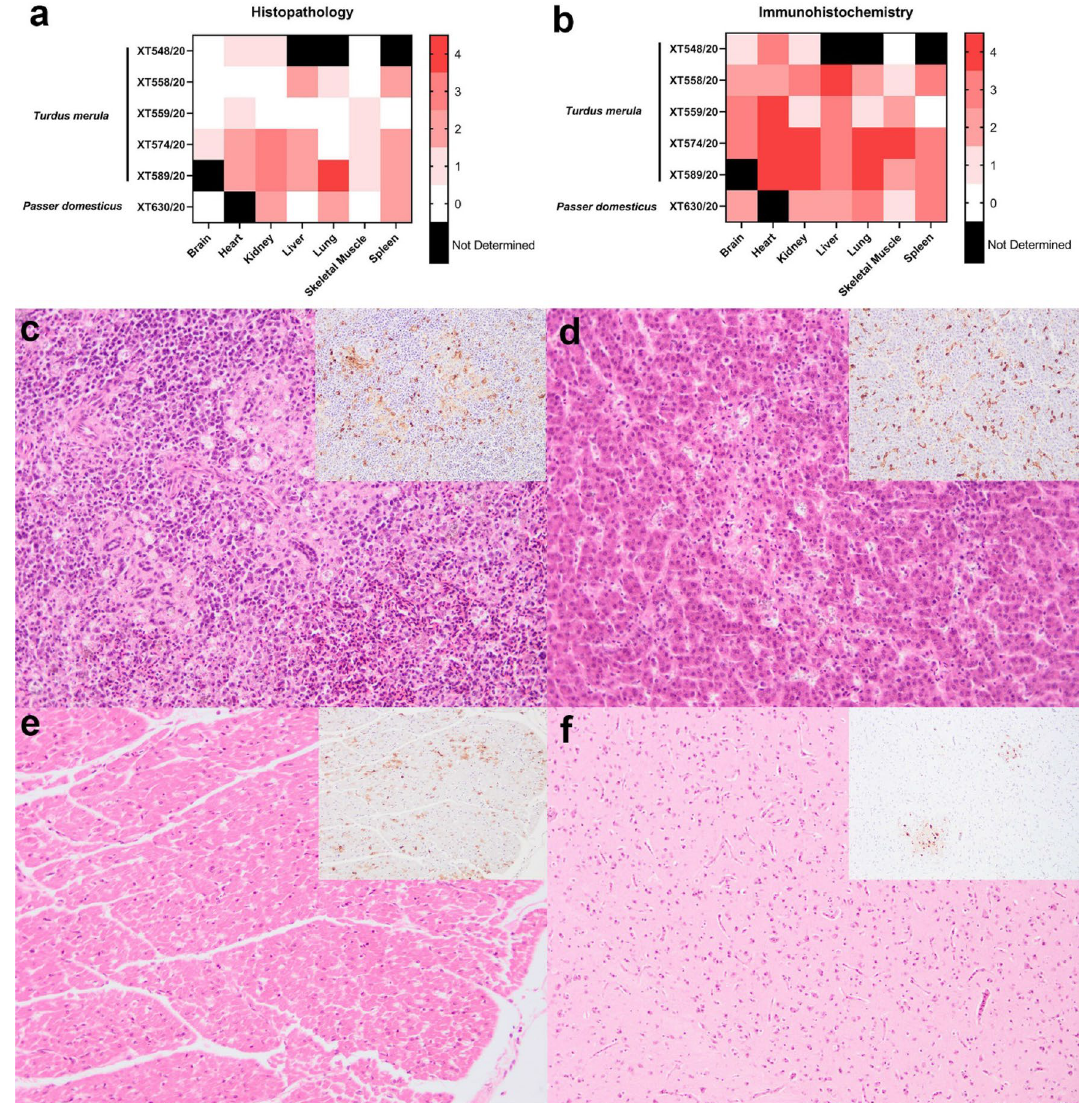
Figure 1. Histopathological and immunohistochemical findings of Eurasian blackbirds ( Turdus merula ) and house sparrow ( Passer domesticus ). Categorical heat maps indicate the maximum severity of histopathological changes ( a ) and the level of immunohistochemical labelling against flavivirus envelope ( b ). For histopathology 0 absent; 1 minimal; 2 mild; 3 moderate; 4 marked; for immunohistochemistry: 0 absent; 1 rare; 2 scattered; 3 confluent; 4 abundant. No histopathological findings were considered marked. Black indicates where no samples were available for analysis. Representative histopathology and immunohistochemical sections of tissues from Usutu virus infected blackbird ( c–f ). Virus antigens are associated with areas of necrosis in the spleen ( c ) and liver ( d ) but also present in areas without histological changes. Minimal histological changes in the heart ( e ) and brain ( f ) but with moderate and scattered amount of virus antigens in respective tissues. Serial sections are stained with haematoxylin and eosin and flavivirus anti-envelope antibody (insets). Original magnification 200x. Histology scores: 2 (spleen, liver, heart), brain (1). IHC scores: 3 (spleen, liver), 4 (heart), 2